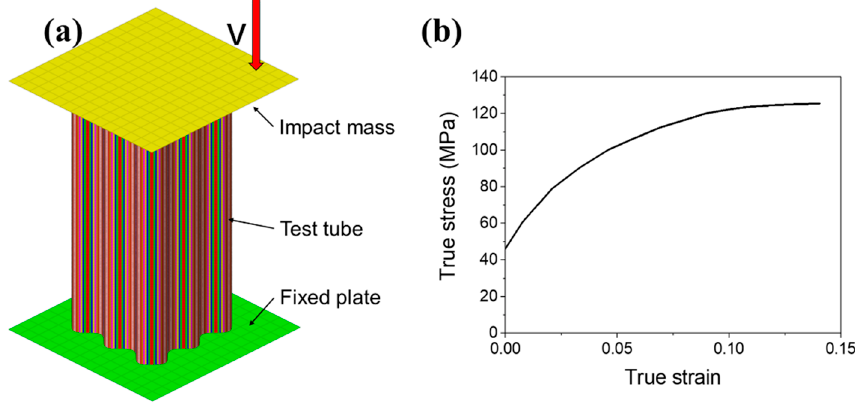
Figure 4. FE model of the MCCT under axial loading : ( a ) FE model and ( b ) stress-strain curve of the material aluminum alloy AA 6061O.